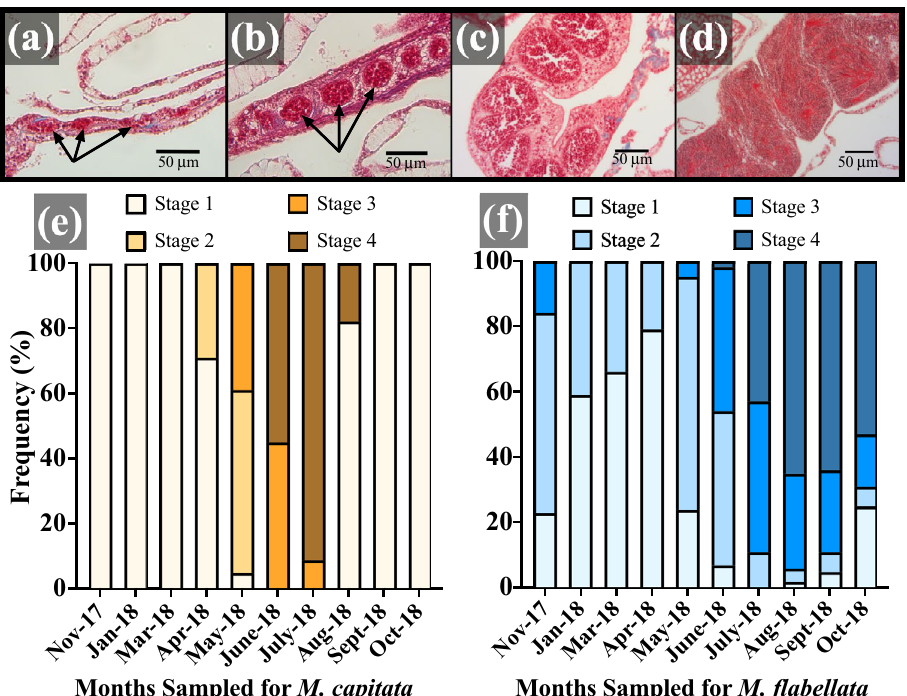
Figure 7. Sperm developmental stage frequency distribution per month. Stages of spermatogenesis; arrows point to a cluster of developing male germ cells. (a) stage I spermaries with cluster of spermatogonia; ( b ) stage II spermaries with spermatocytes; ( c ) stage III spermaries with spermatocytes around central lumen; ( d ) stage IV spermaries with spermatozoa tails projecting into lumen; ( e ) M . capitata and ( f ) M . flabellata spermary stage percent frequency per month sampled. All scale bars 50